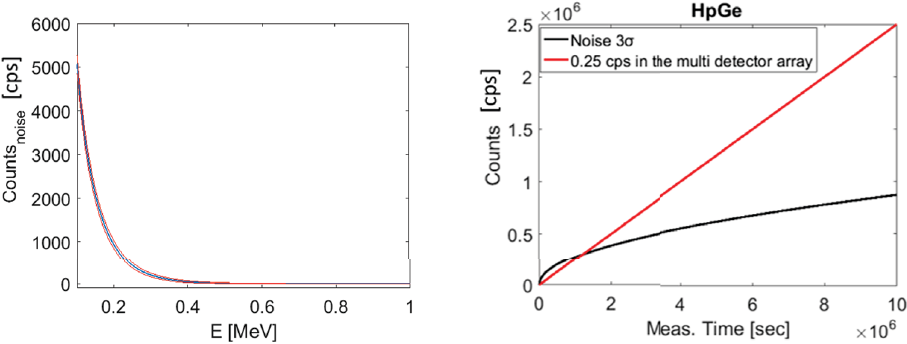
Figure 2. Left - typical noise spectrum, due to plasma self-emission. Right - trend of the real signal counts (in red), considering a rate of 0.25 cps (counts per second) in the multi HpGe detector array, and of the 3 σ the noise level (in